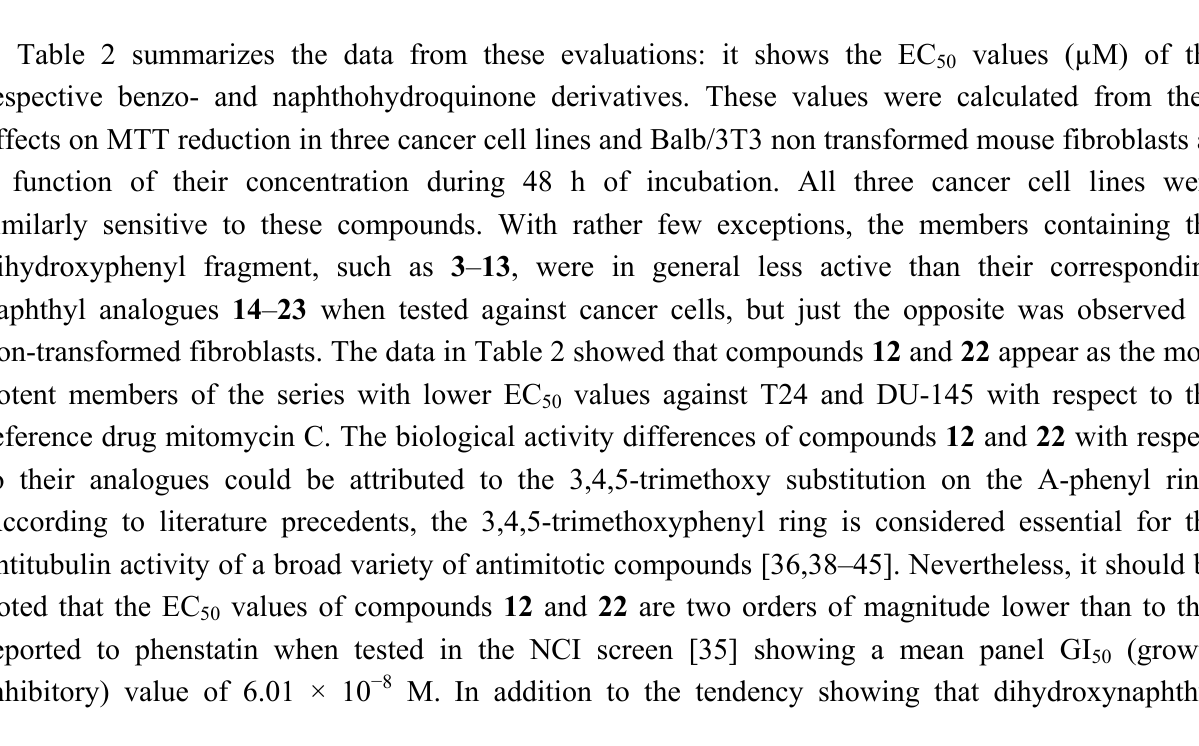
values tumor cells; c DOX: doxorubicin; d MIT: mitomycin 50